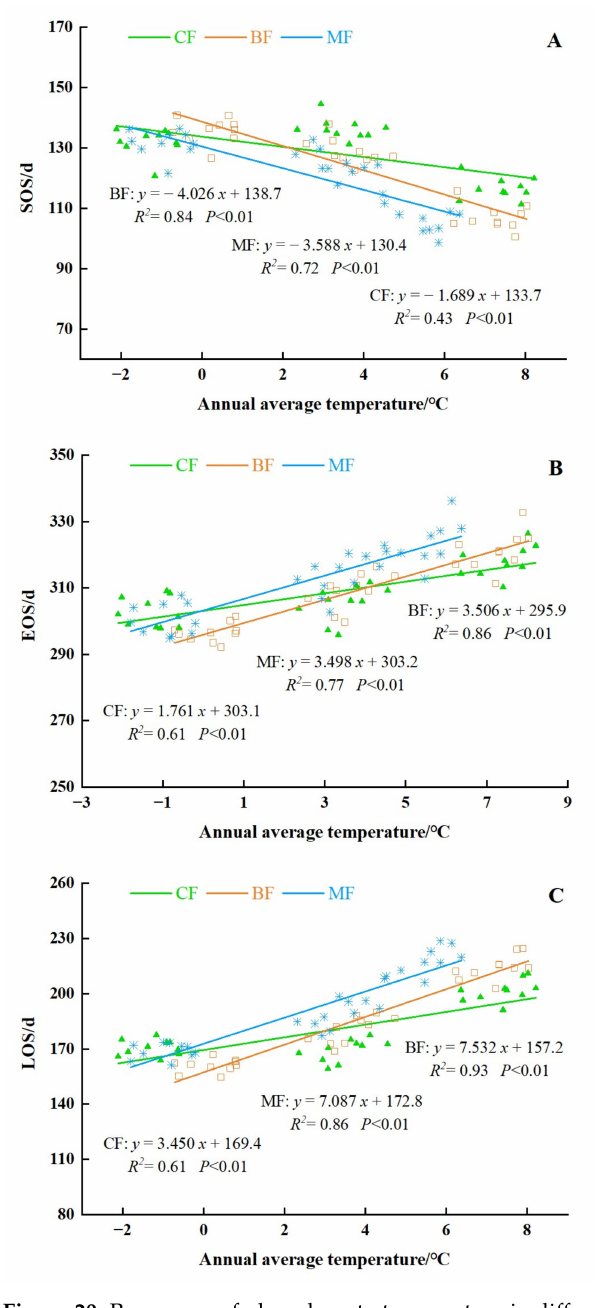
Figure 20. Responses of phenology to temperature in different forest types in northeast China from 2011 to 2020. ( A ) SOS of different forest types; ( B ) EOS of different forest types; ( C ) LOS of different forest